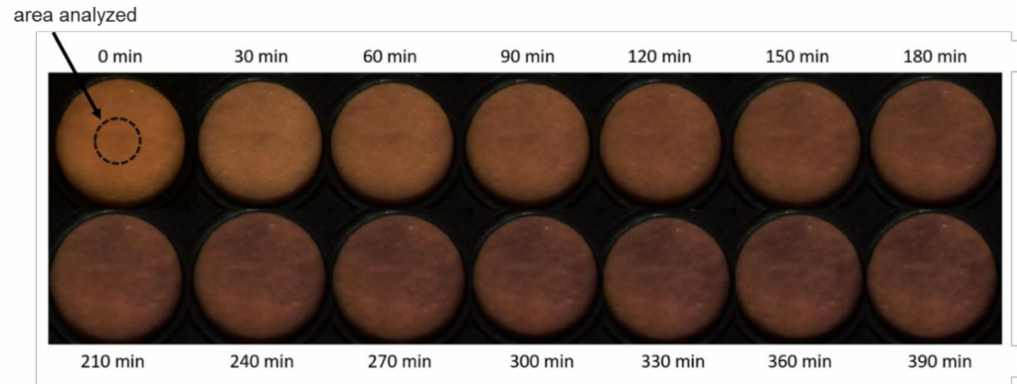
Figure 3. RGB (Red, Green, Blue) images of mangoes during drying (0 min till 390